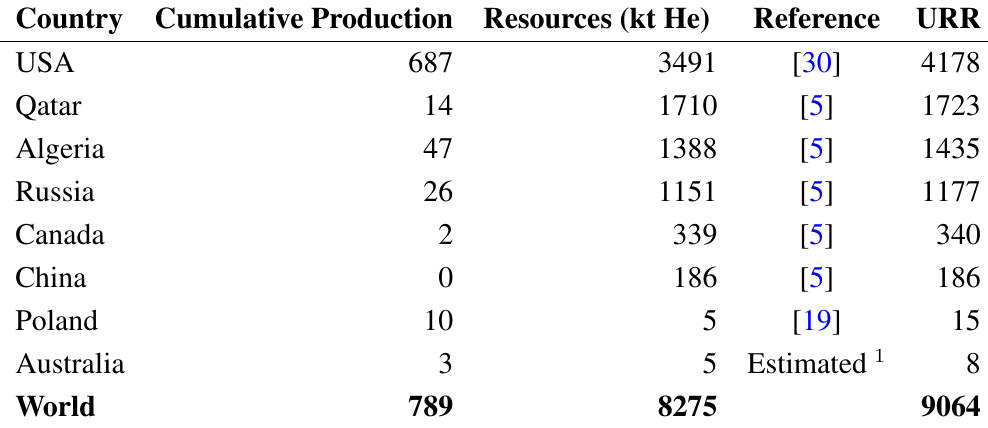
Table 2. The helium resources of the world by country.